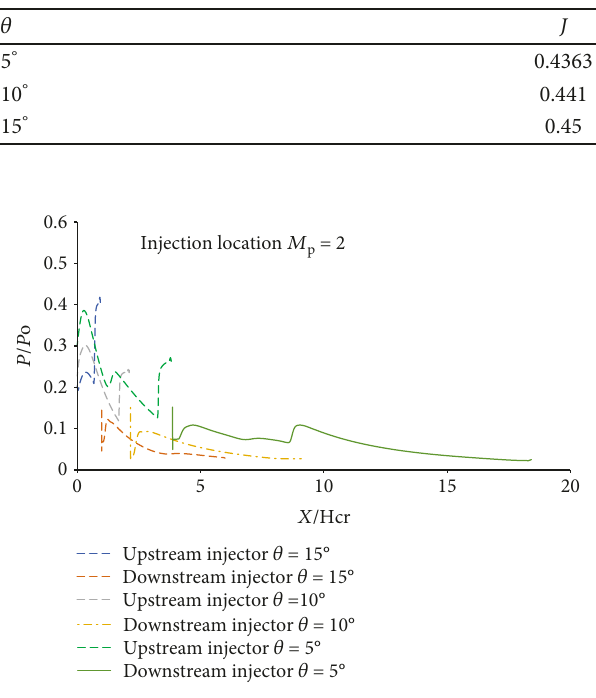
Figure 19: In fl uence of the divergence half angle on injector wall static pressure distribution M